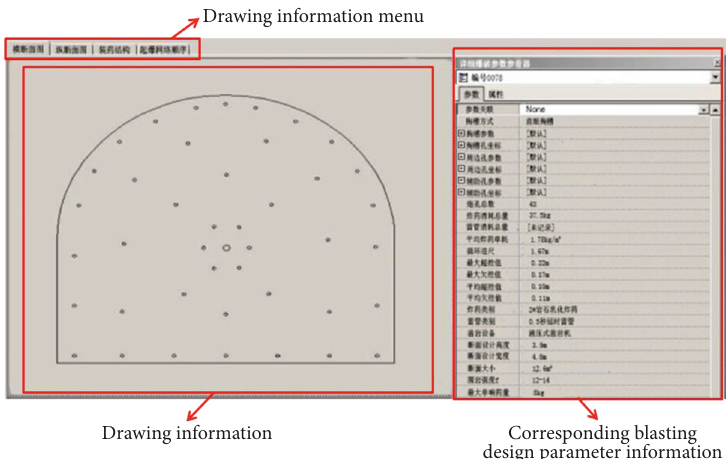
Figure 15: Blasting parameter table and blasting hole